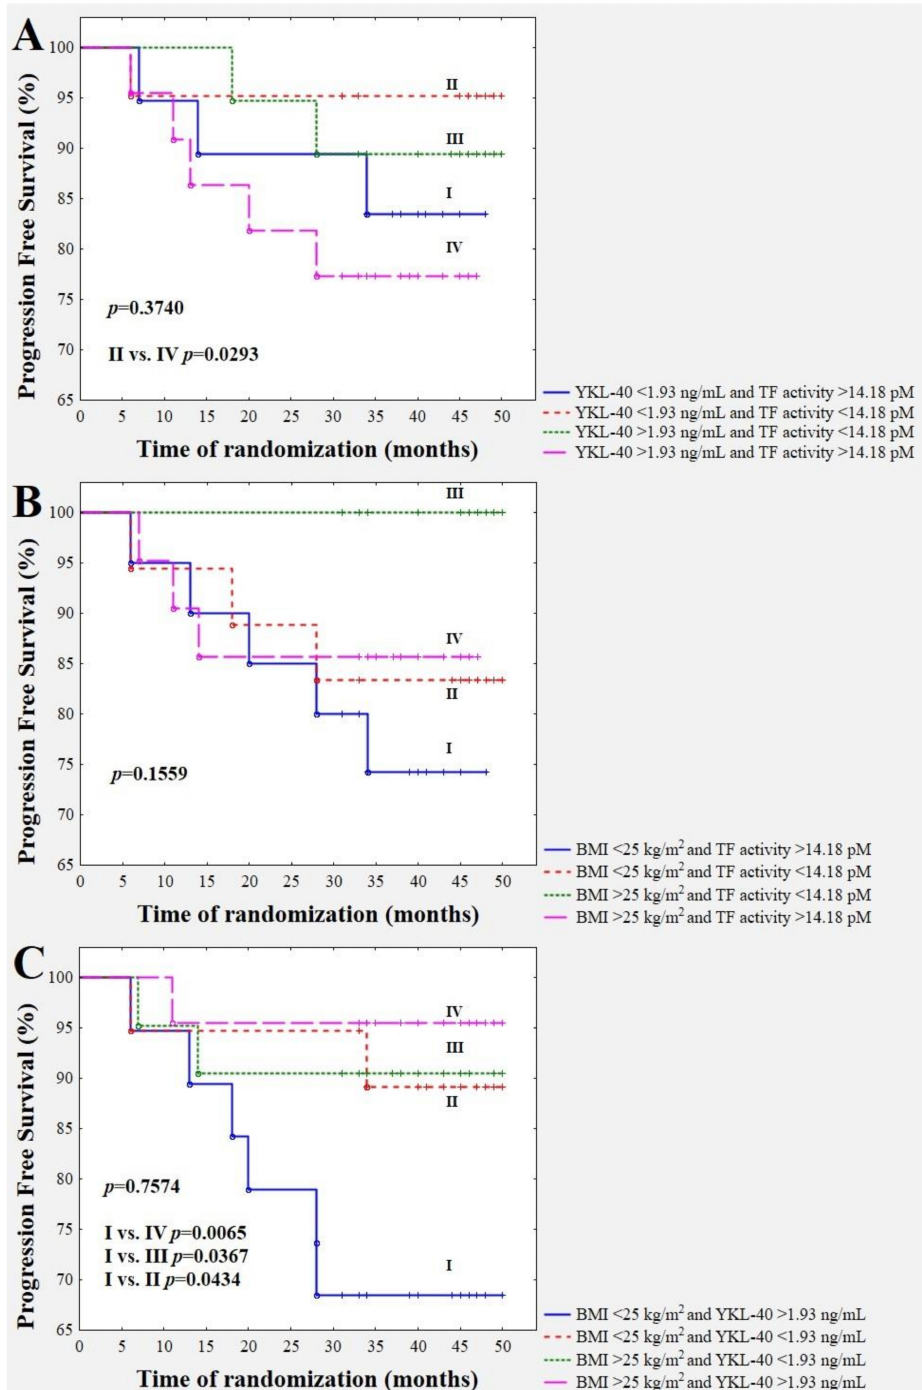
Figure 3. Combination of the YKL-40 level with TF activity ( A ), the value of BMI with YKL-40 ( B ), and BMI with TF activity ( C ), in disease relapse